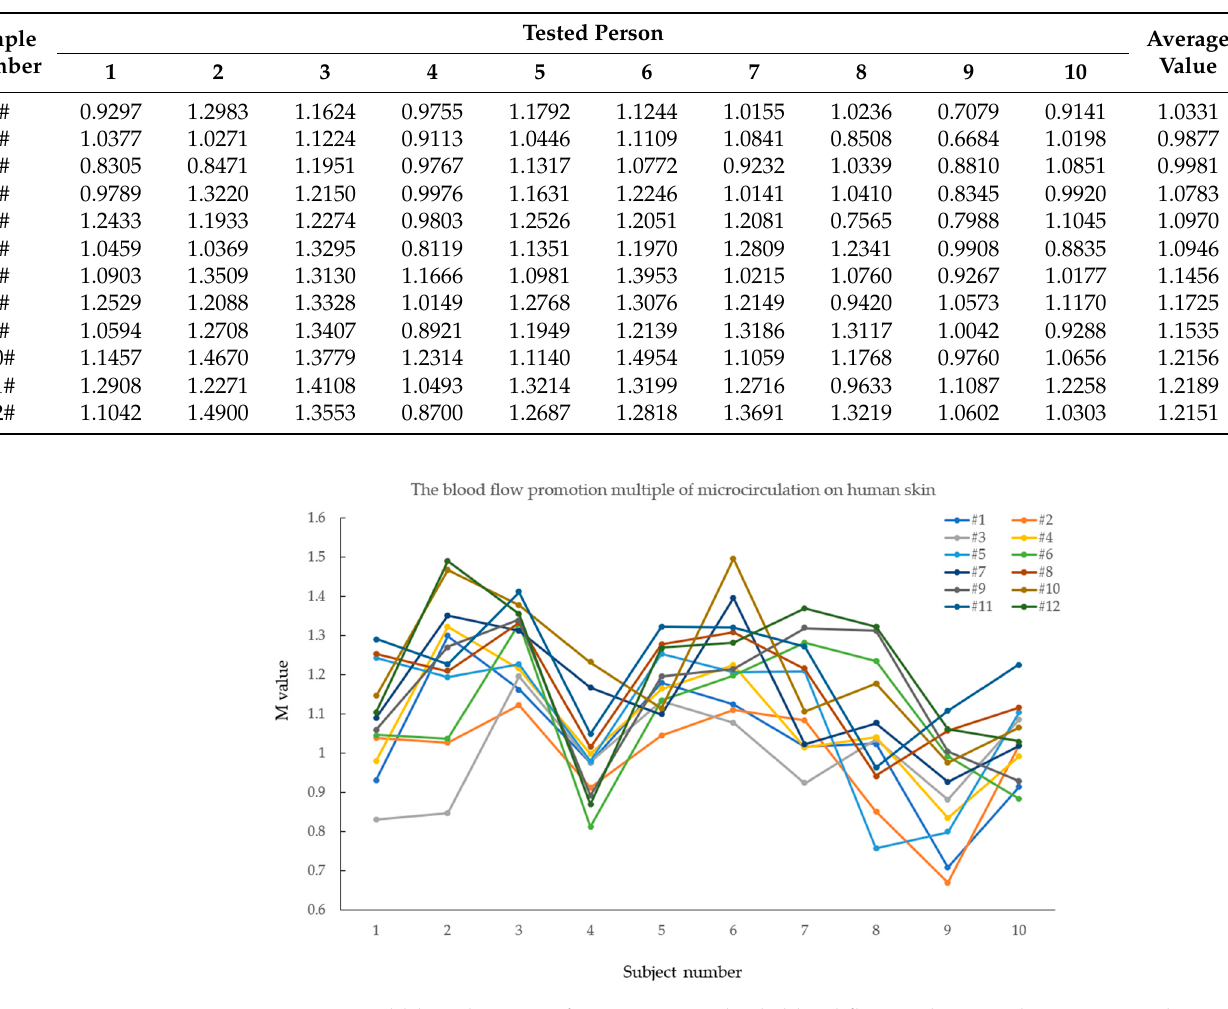
Figure 5. Fold-line diagram of promoting multiple blood flow on human-skin microcirculation of 12 seamless knitted fabrics.